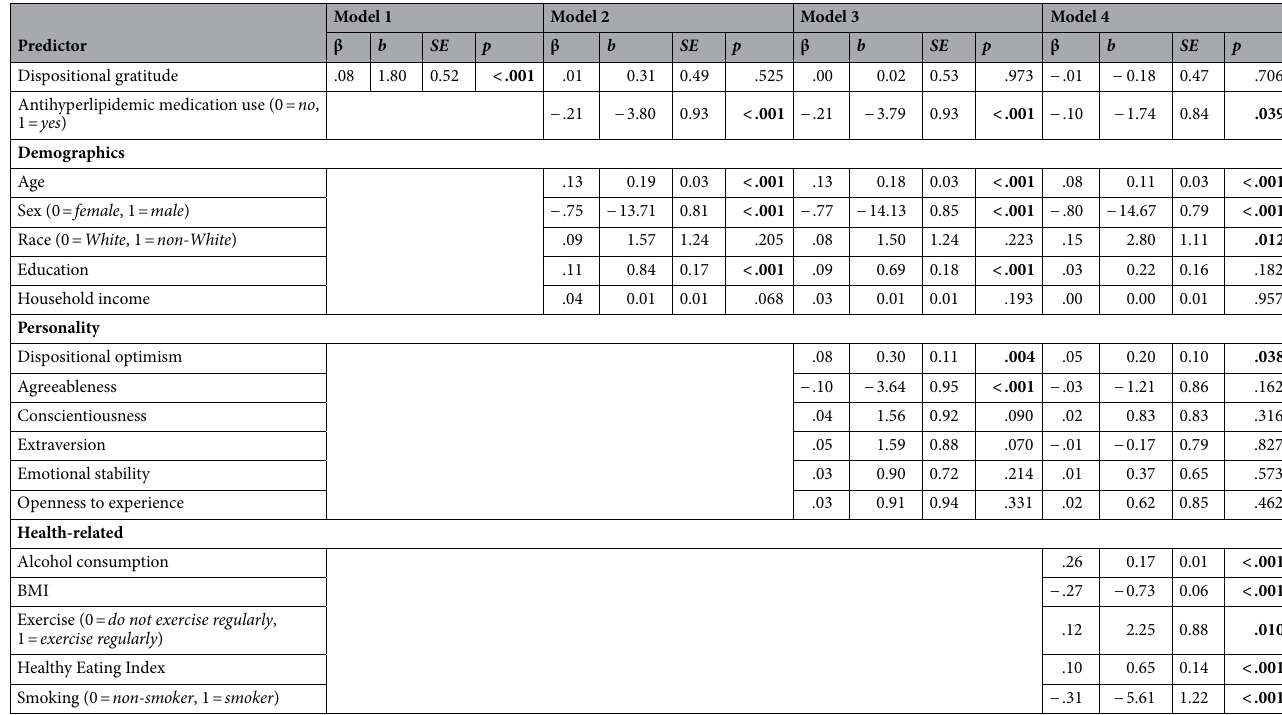
Table 2. Model summaries with HDL as the outcome variable. N = 1800. β = standardized slope coefficient, b = unstandardized slope coefficient, SE = standard error of the slope coefficient. Bolded p -values indicate statistical significance at the .05